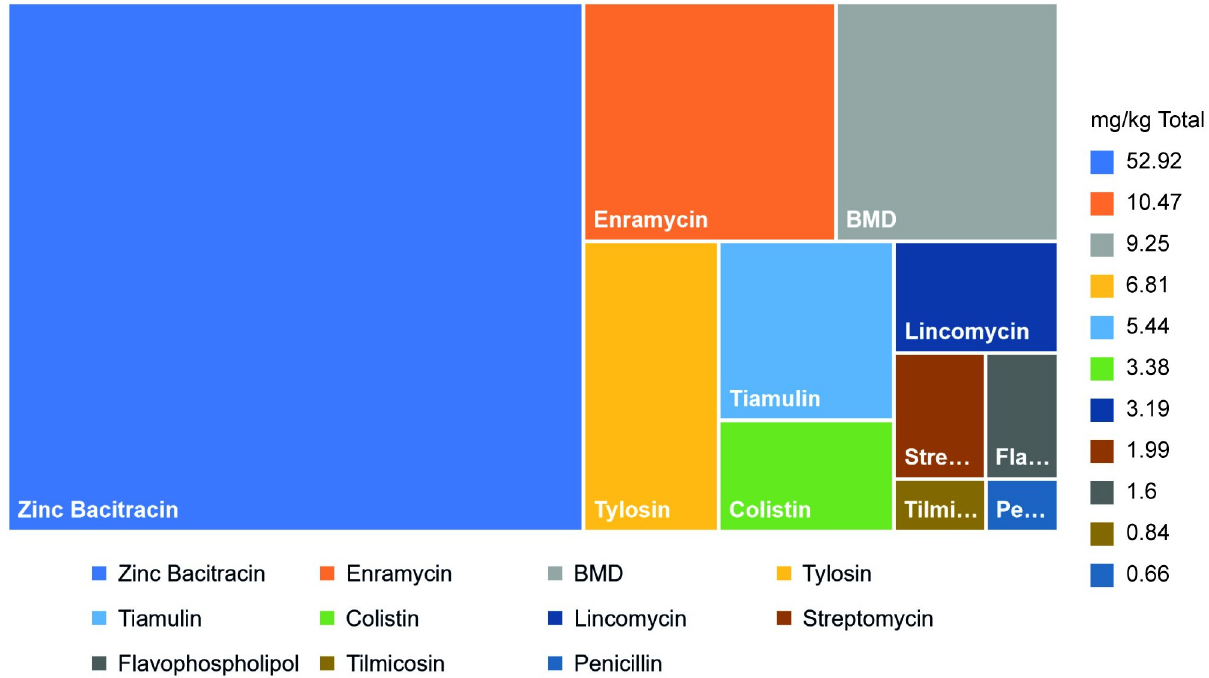
Fig 6. Total import volumes of feed additive/growth promoter antimicrobial chemical compounds adjusted for total chicken biomass for the years 2017–19.